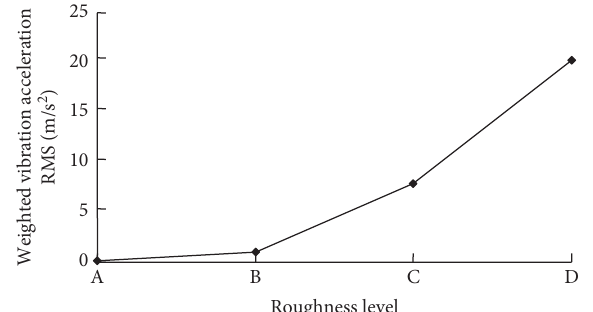
Figure 14: The variation curve of weighted vibration acceleration RMS value of the vehicle